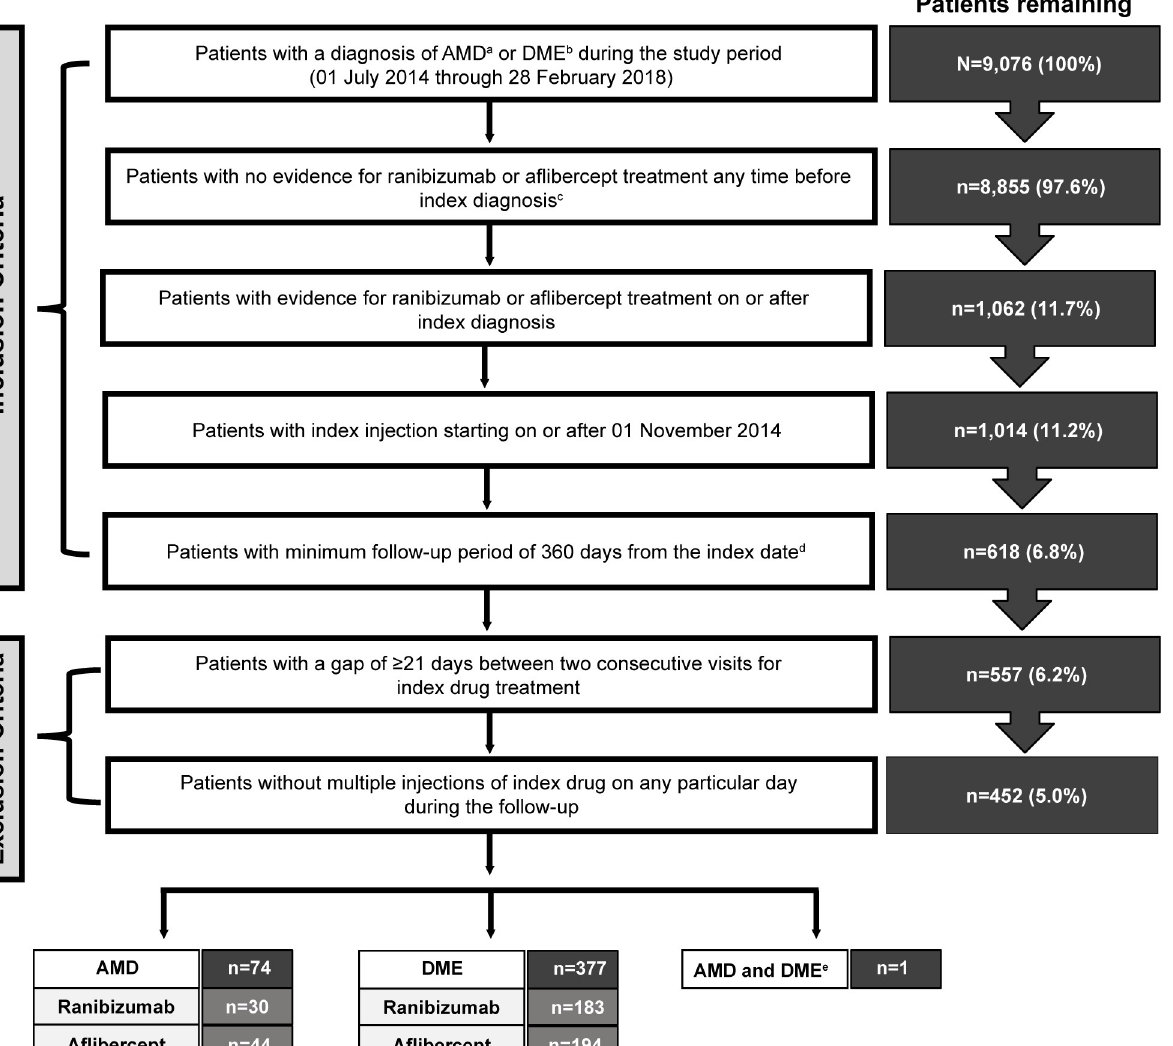
patients with nAMD, the ranibizumab cohort had a relatively lower proportion of patients with diabetes with complications compared with the aflibercept cohort (16.7% vs 22.7%); while in patients with DME, the ranibizumab cohort had a relatively higher proportion of patients with diabetes with complications compared with the aflibercept cohort (95.1% vs 86.6%) ( Table 1 ).